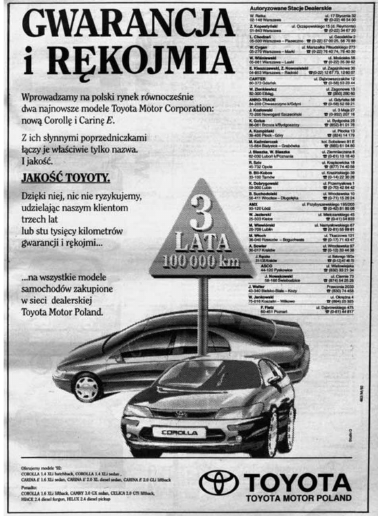
Figure 9. Example of advertising in the hybrid model which illustrates that Toyota provides a 3-year or 300,000 km